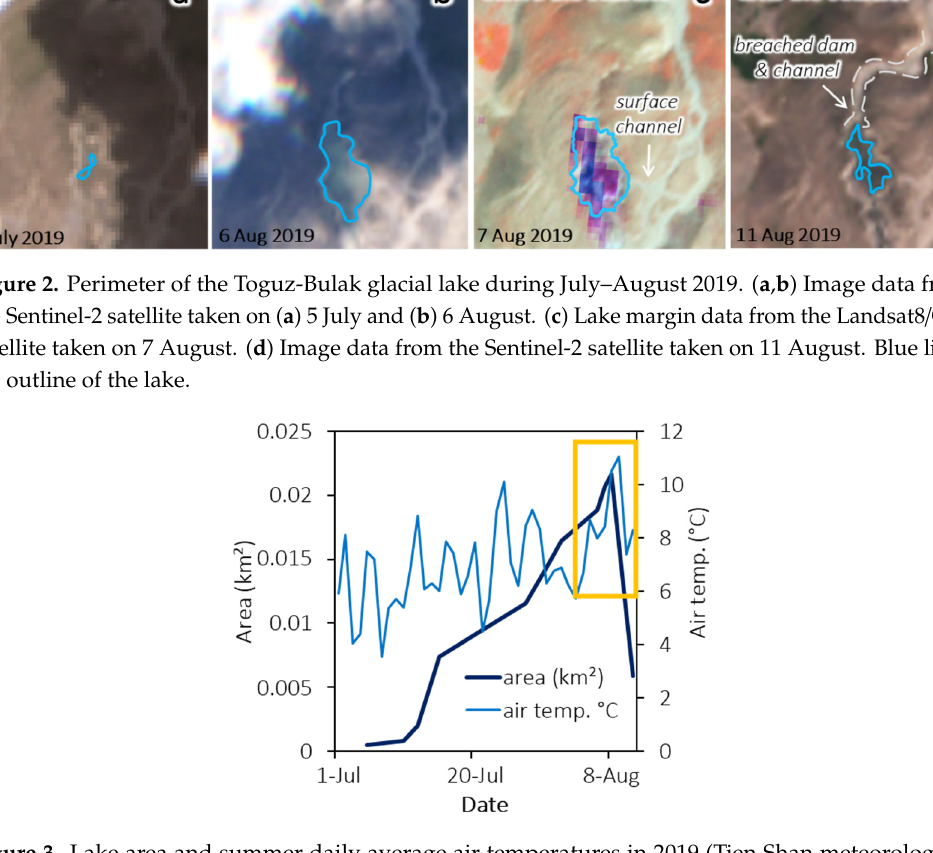
Figure 4. The Toguz-Bulak glacial lake outburst flood. All photos taken on 9 August 2019. ( a ) Lake condition after the outburst. ( b ) Drainage channel through the dam. ( c ) Lake outlet from below and eroded stream banks. ( d ) Flooded area along the Tosor River. Large white arrows show the flow direction. 4.2. Toguz-Bulak Glacial Lake Area Variability during 2010–2019 During 2010–2019, the lake appeared every year in June with a seasonally increasing air temperature and disappeared in September with a decreasing air temperature. The satellite image